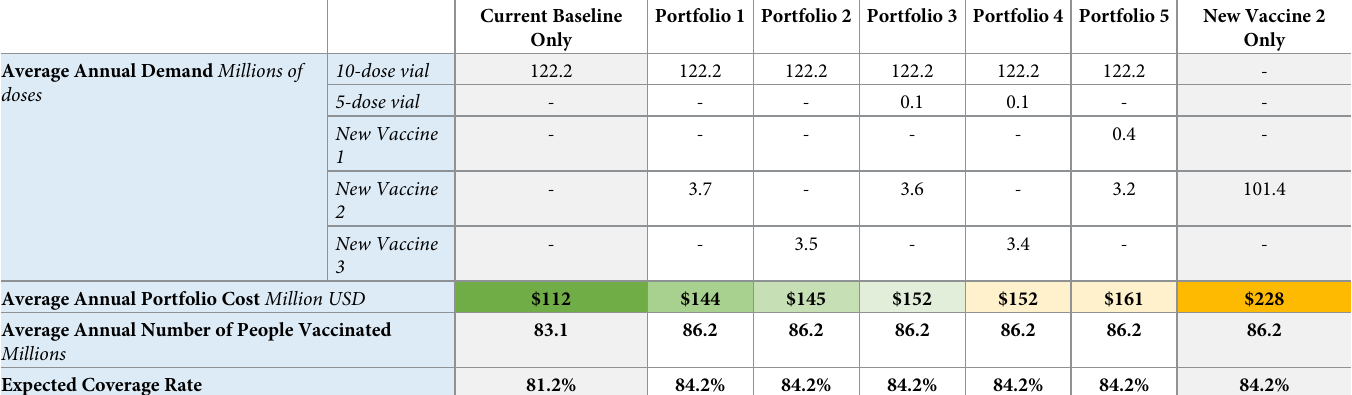
Table 2. Summary of the five lowest-cost portfolio options that achieve the global coverage rate of 84.2% possible under the assumption of “minimum acceptable” characteristics for the new vaccine technologies. All values indicate the average per year over a 10-year period that incorporates population growth. Annual Portfolio Cost, given as NPV, is the buyer-side cost and includes purchase price, service delivery cost, and amortized R&D or capital